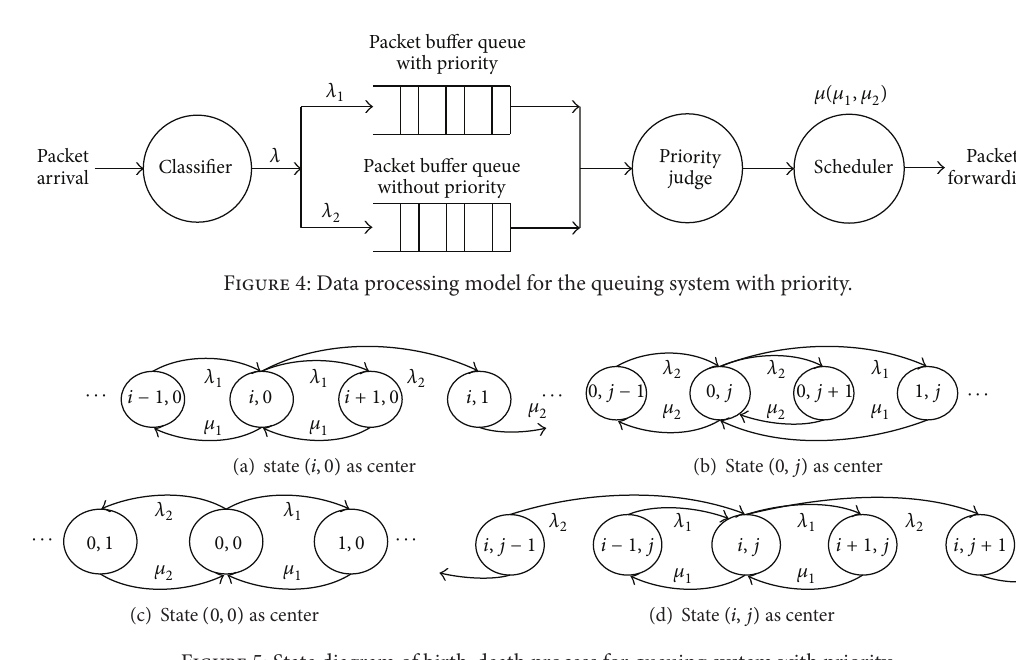
Figure 5: State diagram of birth-death process for queuing system with